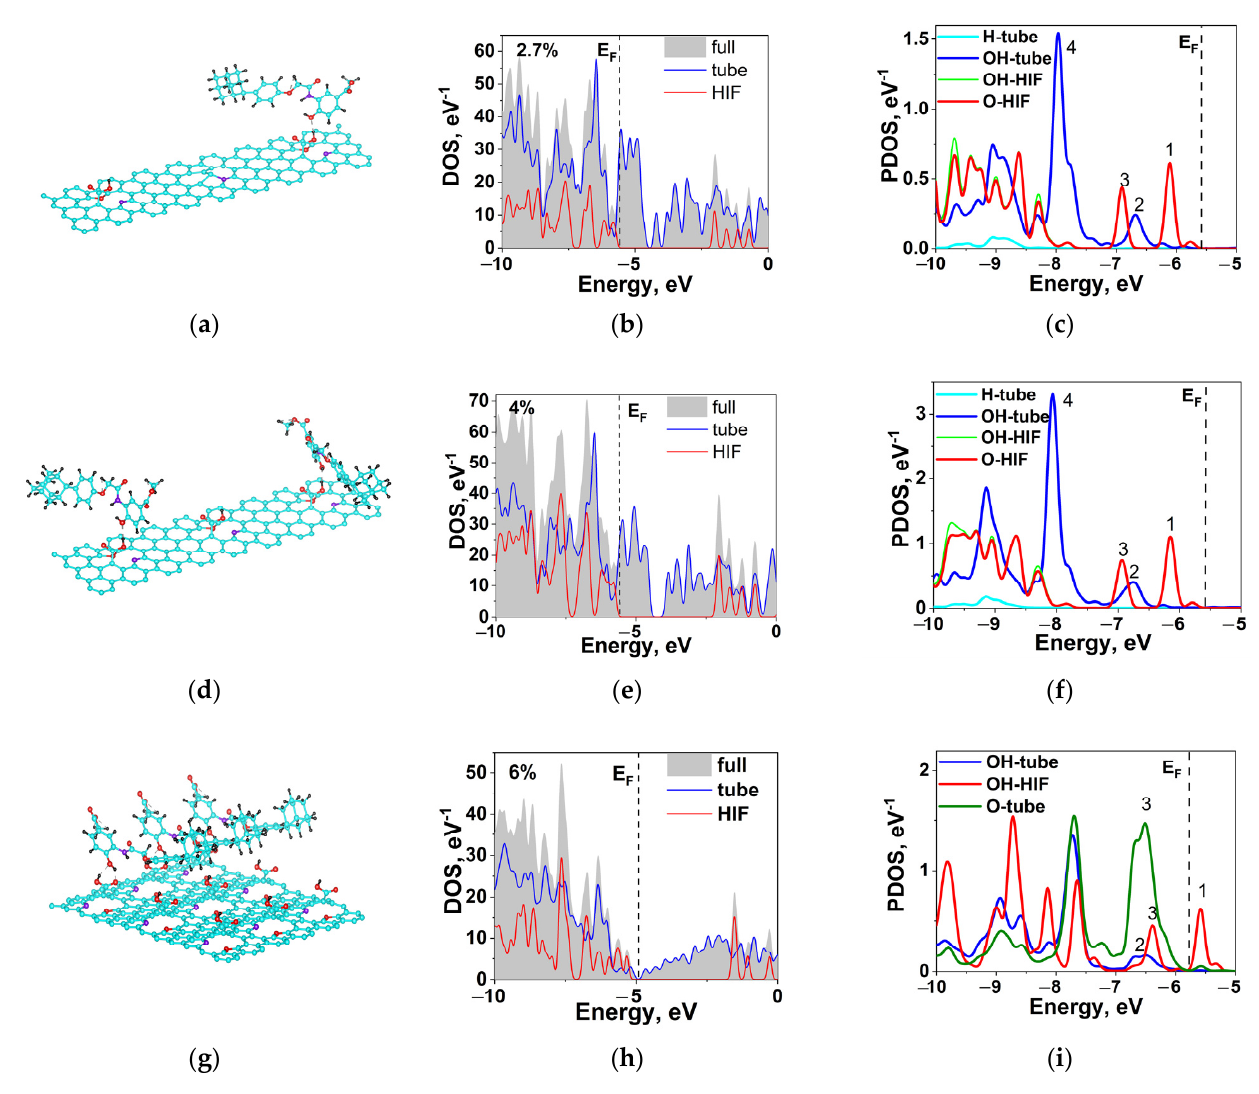
Figure 6. HIF-1 α -COOH-N-MWCNT with S1, S2, and S3: ( a – c ) Atomic structure; ( d – f ), Electronic DOS, and ( g – i ) PDOS.